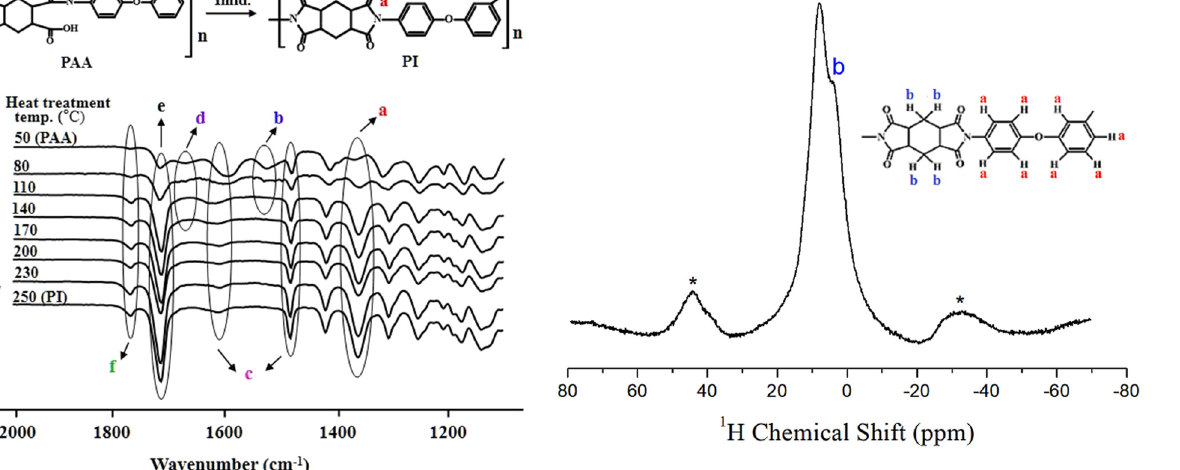
Figure 1: FT - IR spectra of PI as a function of various heat treatment temperatures.